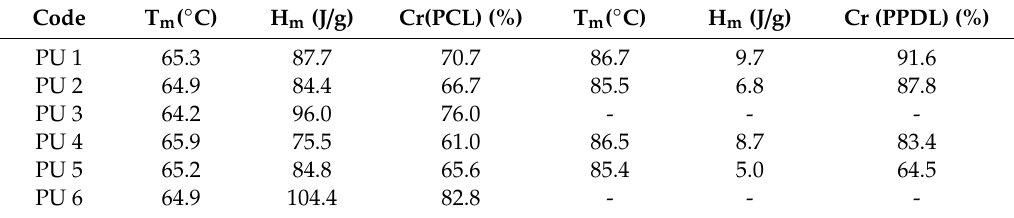
Table 5. Melting temperature (T m ), melting enthalpy ( Δ H m ), and crystallinity values obtained from DSC measurements for PCL and PPDL segments in PUs 1–6 by analysis of the first heating cycle.